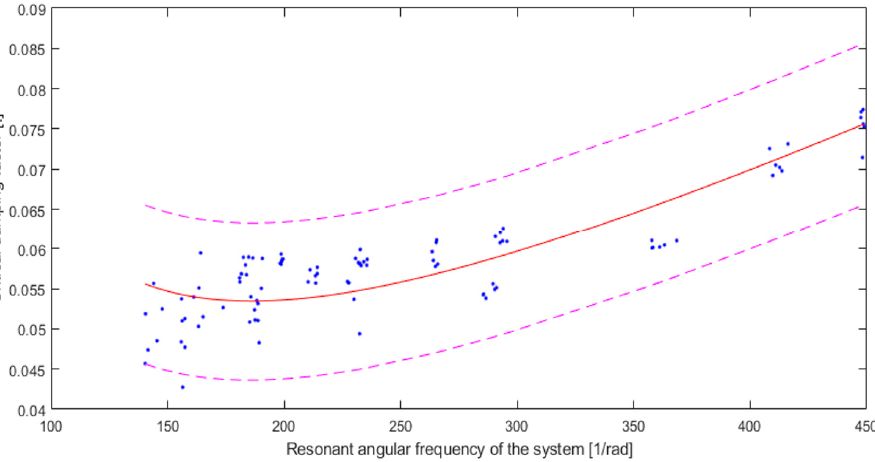
Figure 14. Fitting for Rayleigh damping (solid red line) of measured values (dots) with simultaneous observation confidence bounds 95% (dashed line). R-square: 0.6911.